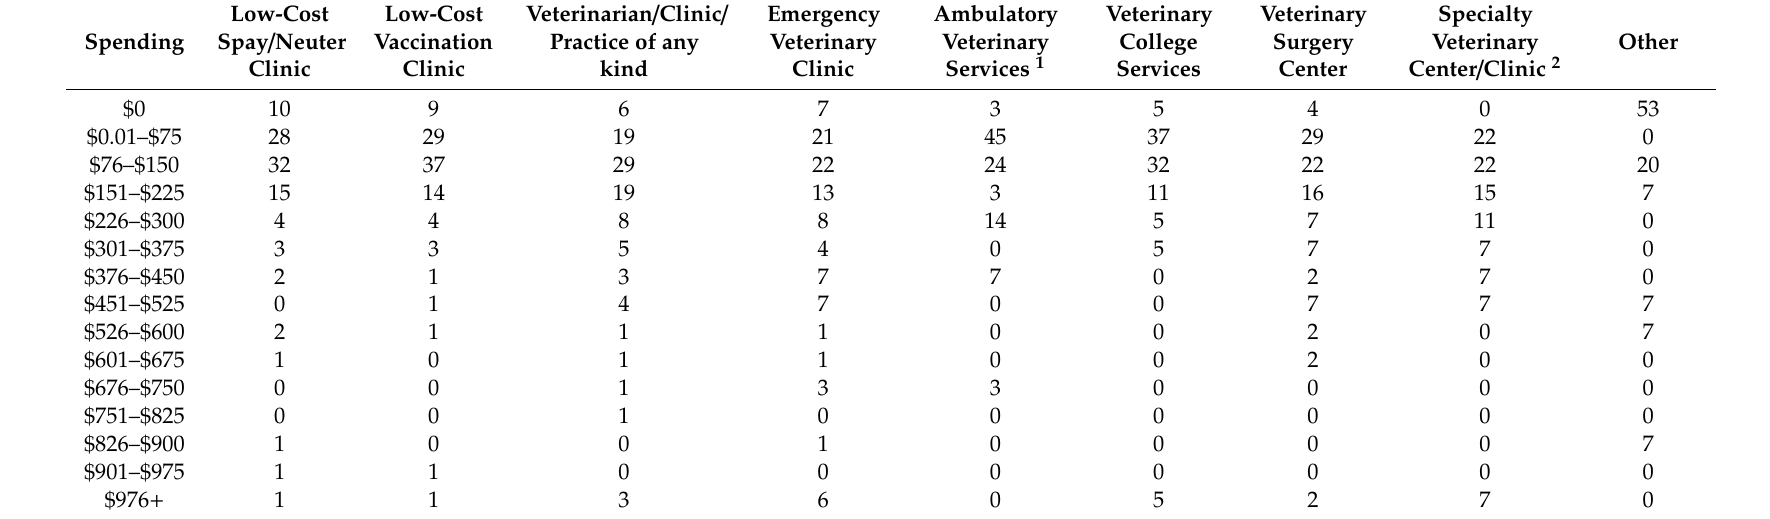
Table A8. Dog owner spending on veterinary related items, percentage of dog (n = 480) owners, by income